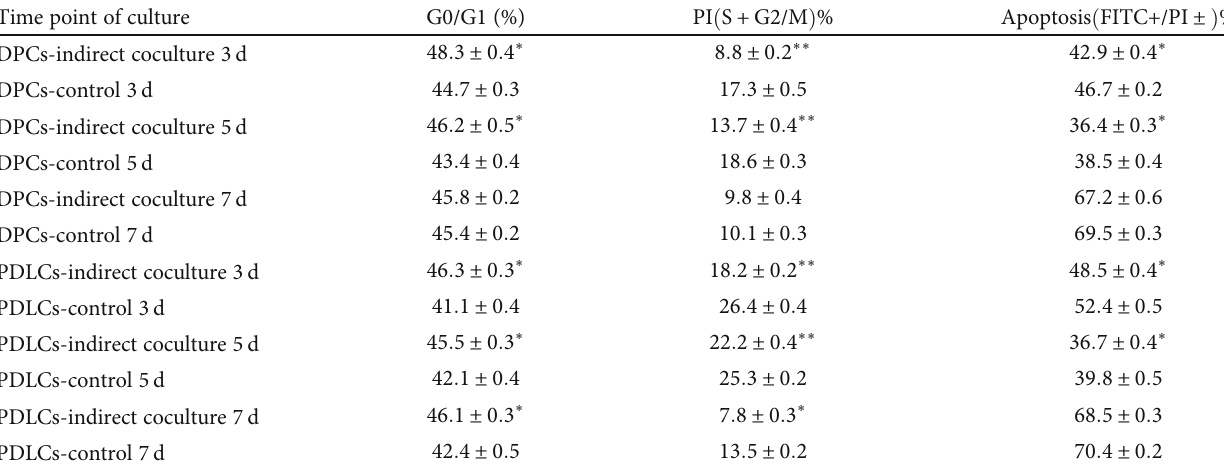
Table 2: The cell cycle and apoptosis of DPCs and PDLCs with indirect coculture ( mean ± SD % ; N = 3 ). Time point of culture